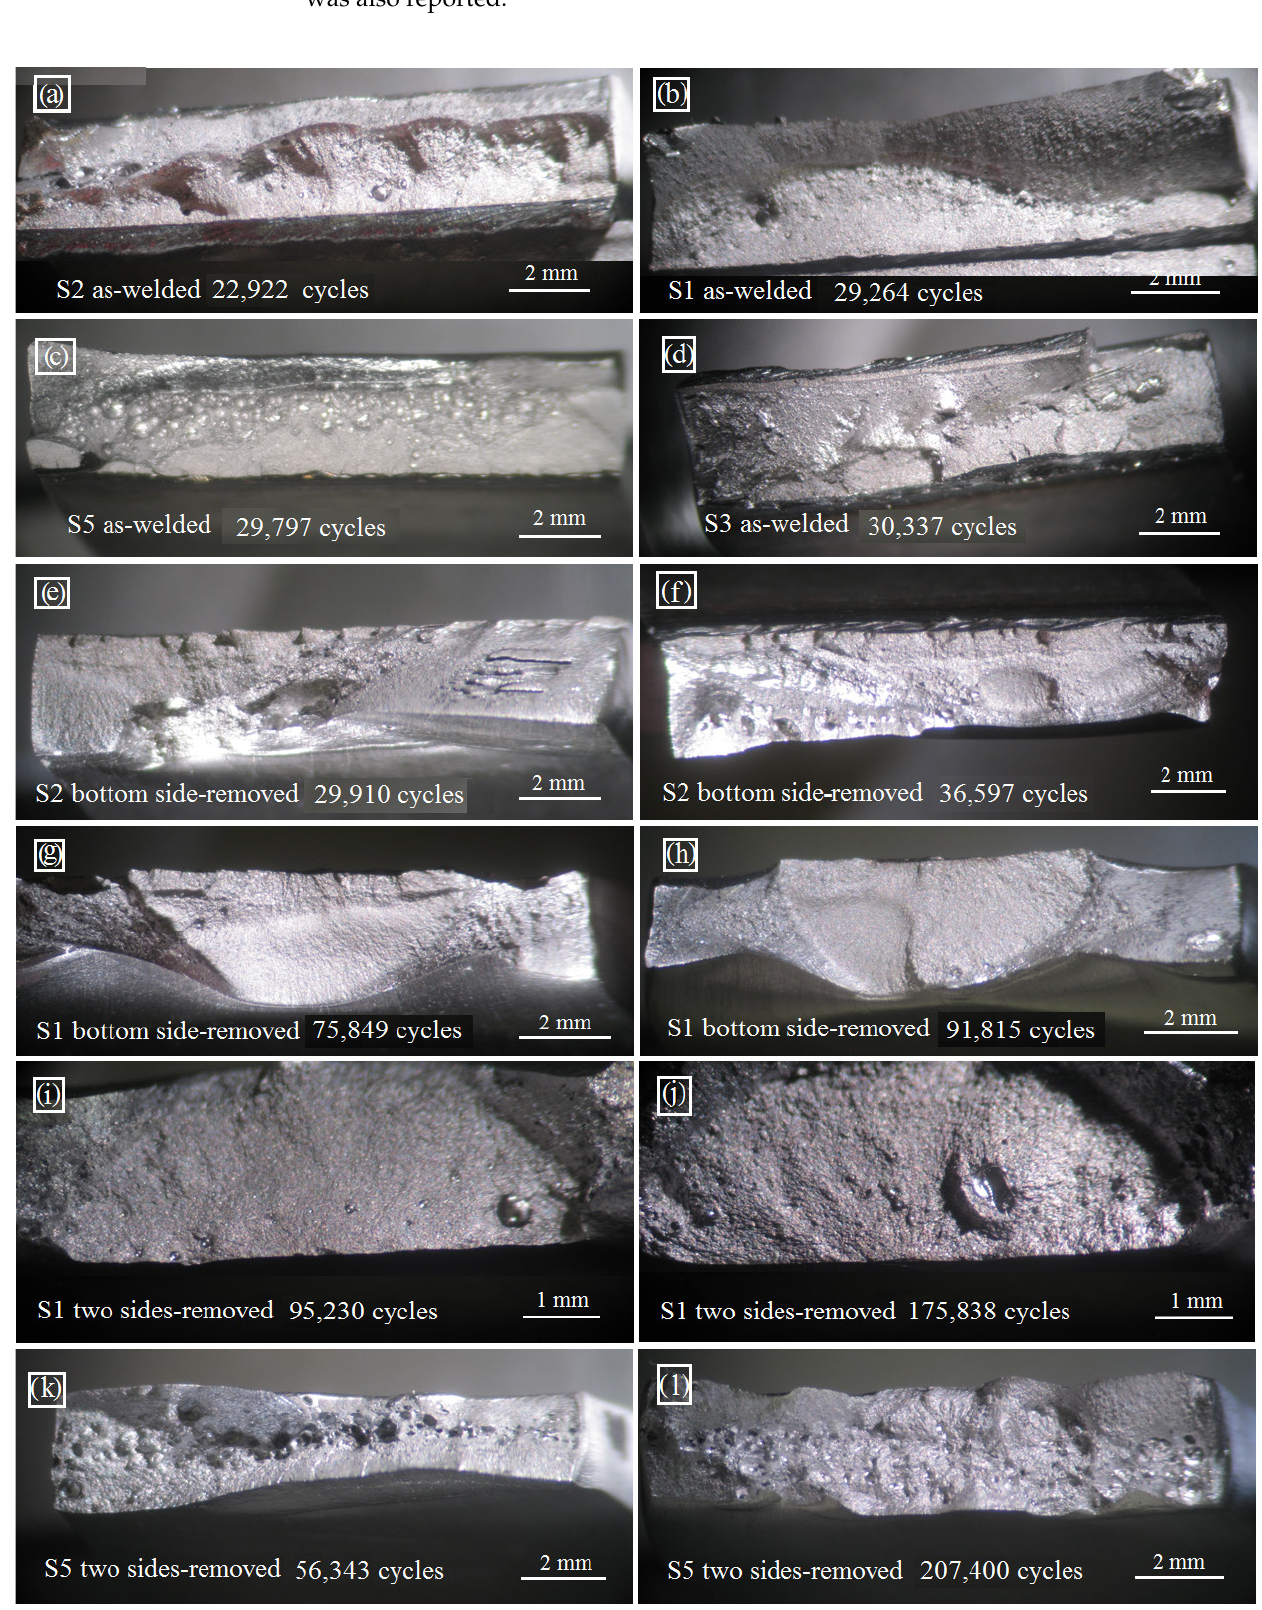
Figure 9. Fractured surfaces of specimens at 600 MPa, from the shortest life (a) to the longest life (l). In the last specimens of the S5 series shown in Figure 9k–l, it is relevant that once the imperfections on both sides of the weld beads were removed, the fatigue failure corre- sponded to pores; surface pores located on the lateral side for the specimen with shorter